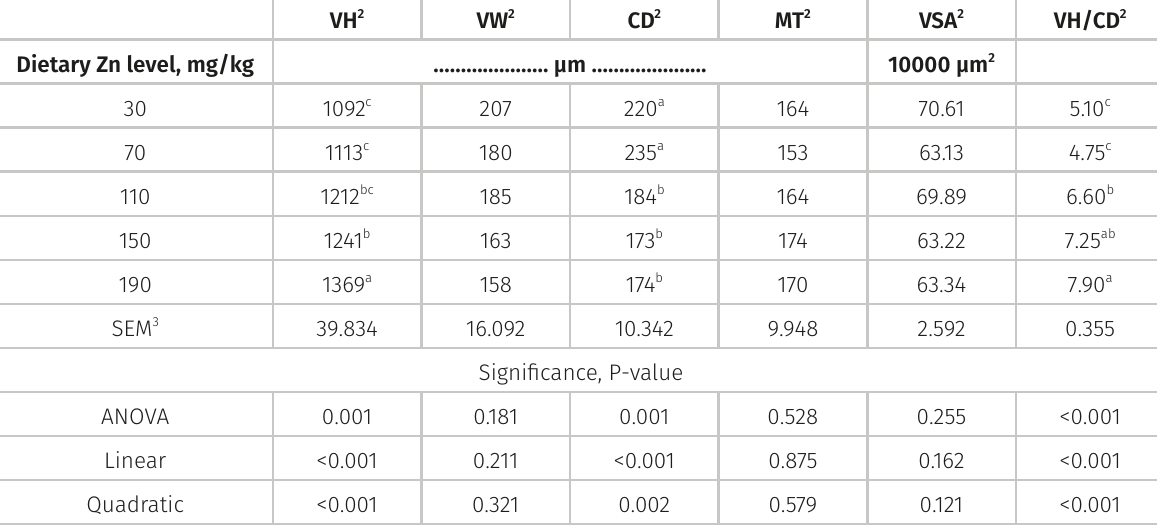
Table VI. Effect of dietary Zn concentration on jejunum histomorphological measurements in broiler chickens fed wheat-soy diets 1